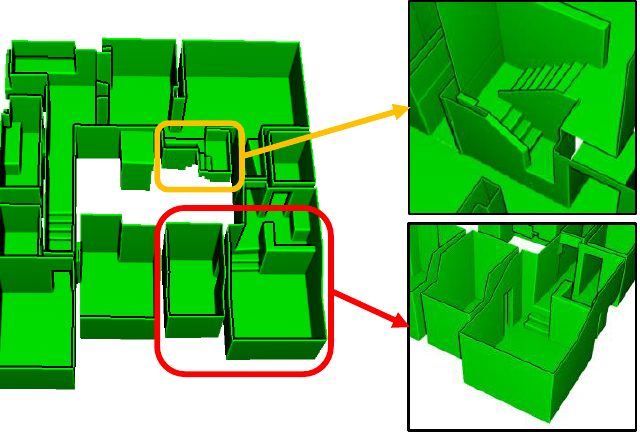
Figure 2. Mesh model built using our proposed method of indoor structure modeling includes inter-room (doors or openings) and inter-floor connections (stairs), denoted by the red and yellow boxes,